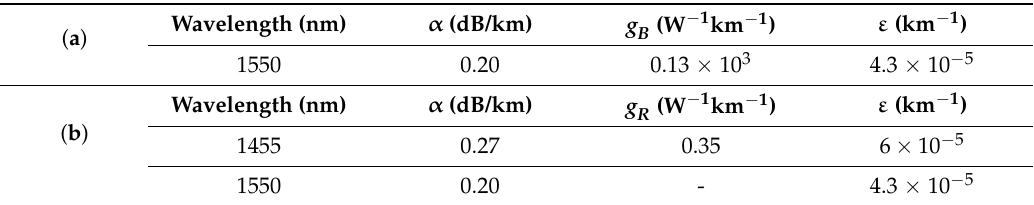
Table 1. Working conditions of the pump schemes: ( a ) for the Brillouin amplification, ( b ) for the Raman amplification.